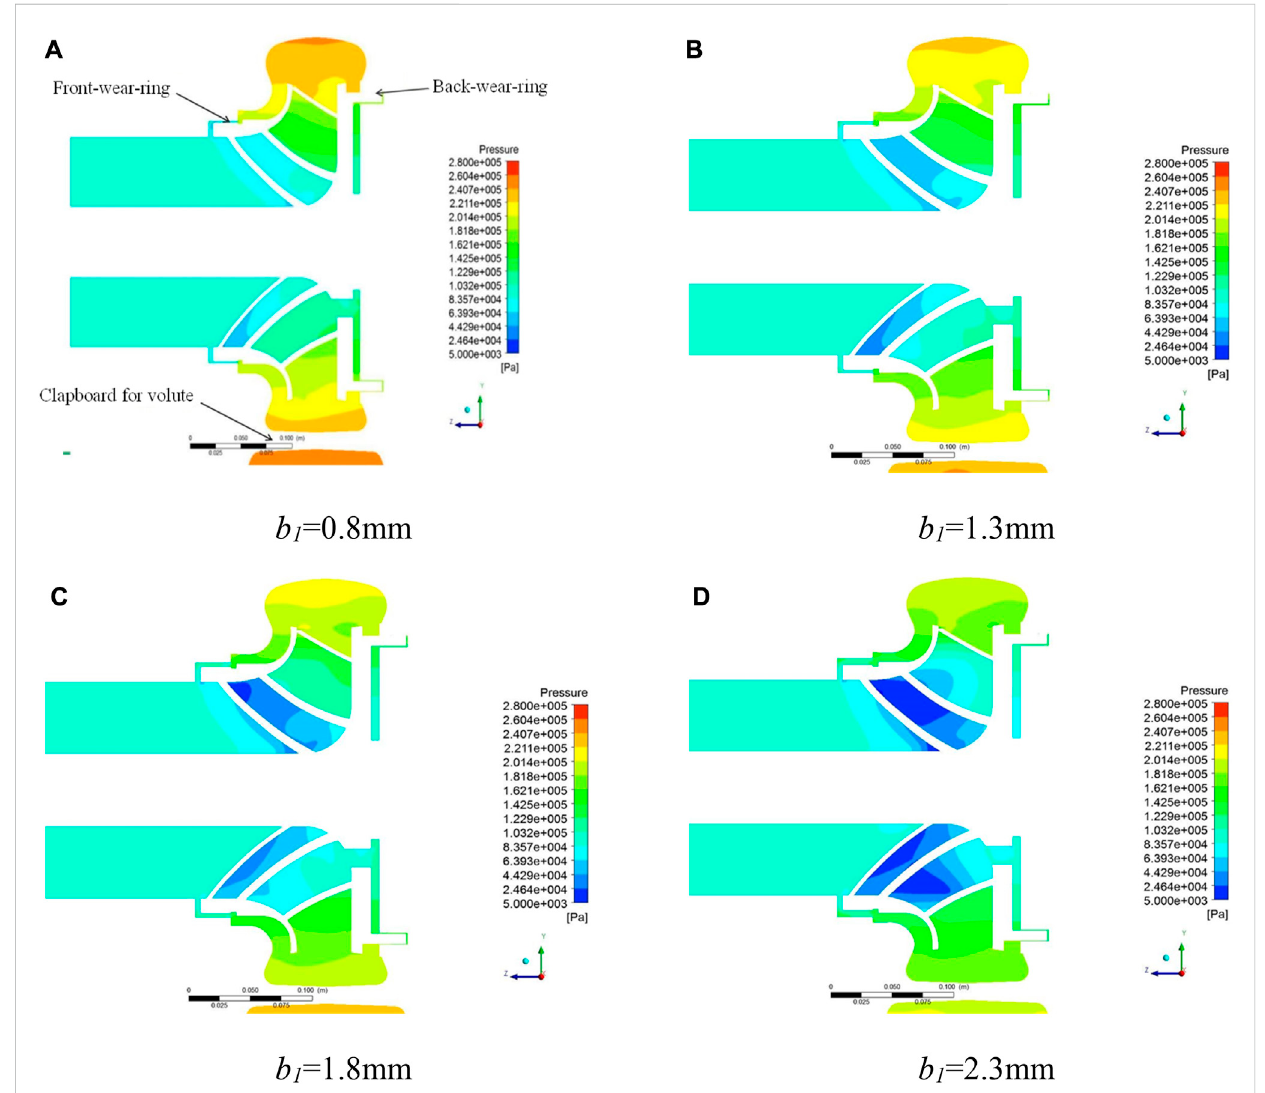
FIGURE 6 ThestaticpressuredistributionofX=0sectionunderdifferentclearanceoffrontwear-ring. (A) b 1 =0.8 mm; (B) b 1 =1.3 mm; (C) b 1 =1.8 mm; (D) b 1 = 2.3 mm.